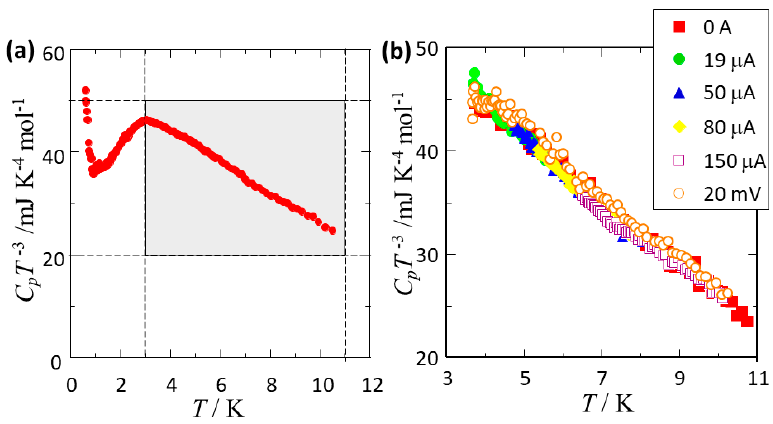
Figure 6. ( a ) Temperature dependence of the heat capacity of θ -(BEDT-TTF) 2 CsZn(SCN) 4 for the single crystal sample used for the present experiment obtained by the standard relaxation technique. ( b ) Those obtained with constant current of I = 0, 19, 50, 80, 150 μ A and V = 20 mV are shown in C p T − 3 vs. T plot. The rectangle area shown by the light blue color in ( a ) corresponding to the whole area shown in ( b ).